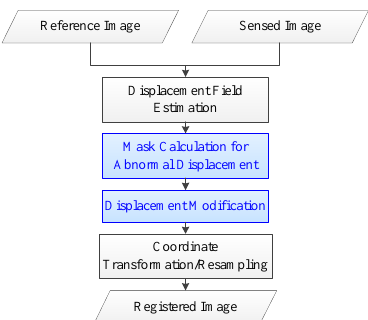
Figure 1. Mountainous remote sensing image registration.